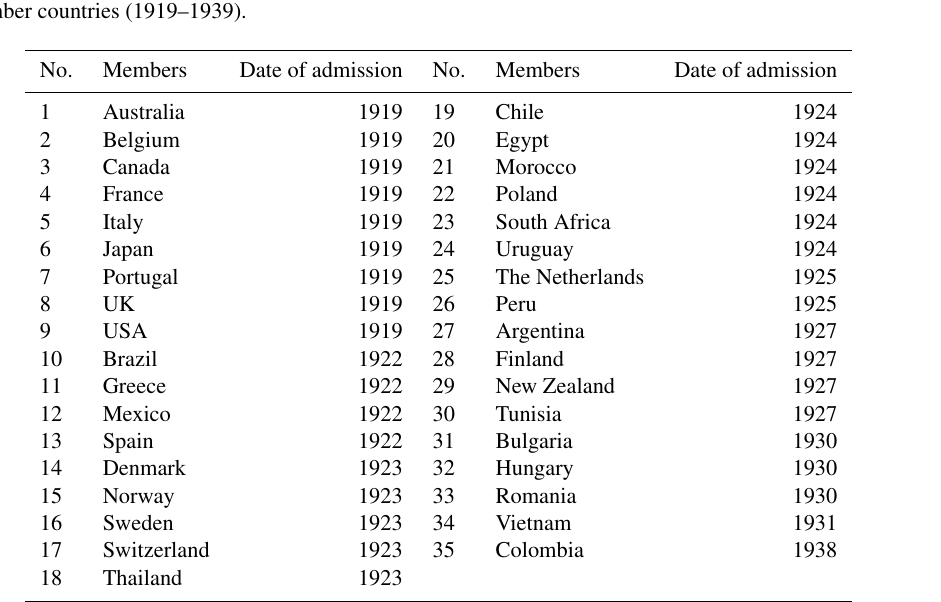
Table 2. IUGG Member countries